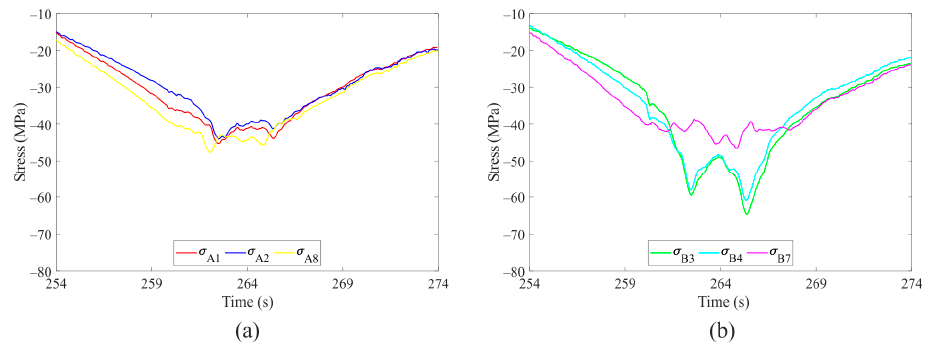
Figure 12. View of the rail welded to girder B.